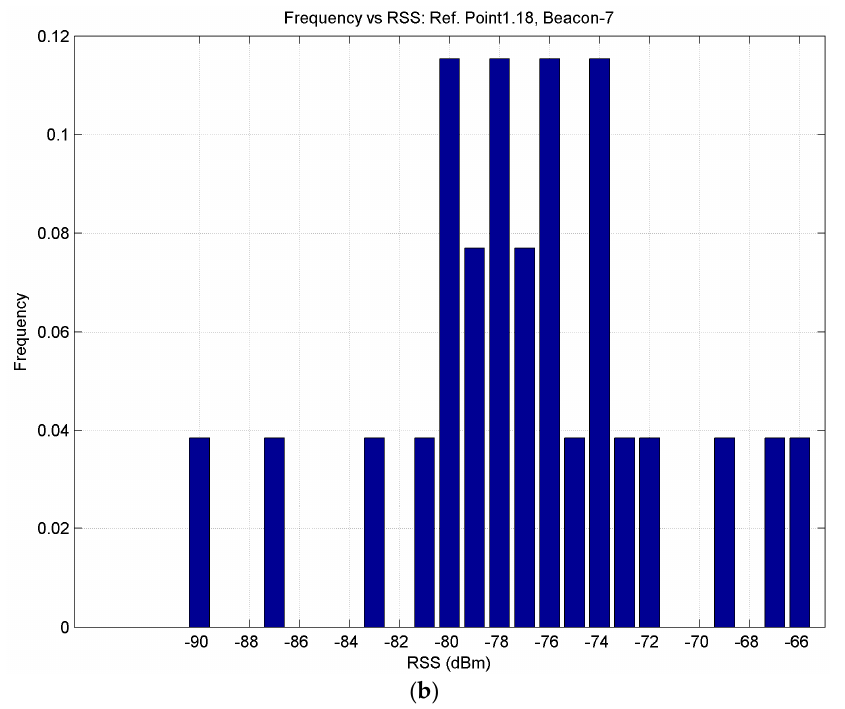
Figure 16. Histograms of RSS values for two beacons: ( a ) Beacon 1 in the absence of passengers; ( b ) Beacon 7 in the presence of passengers.